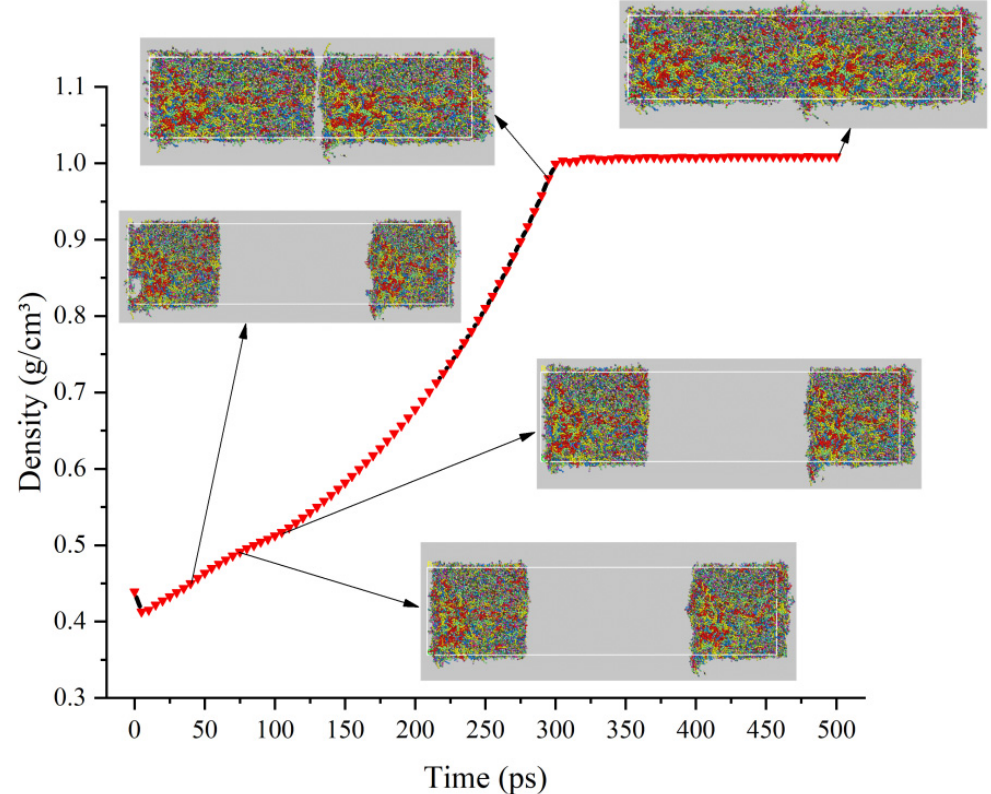
Figure 7. The density of the model in the process of self-healing.